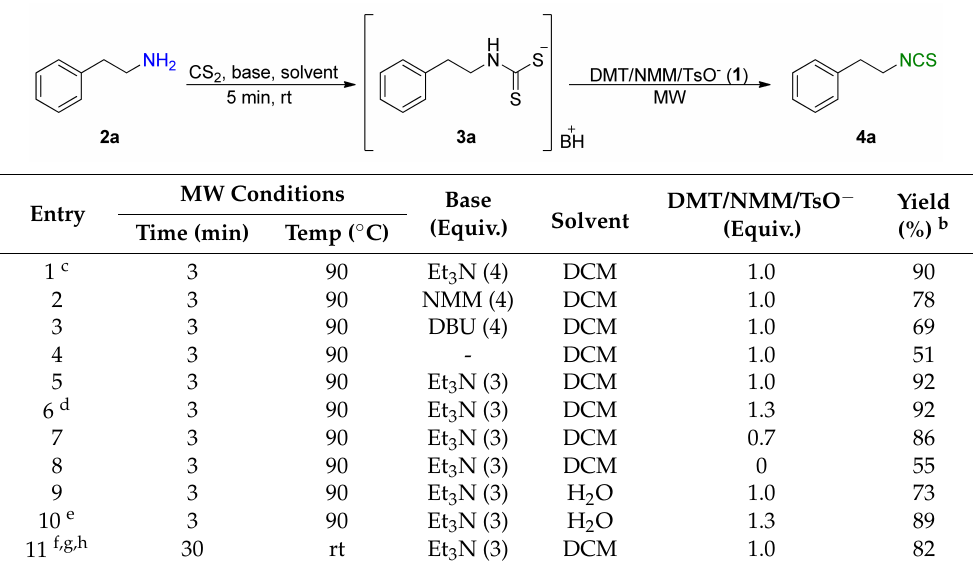
Table 1. Optimization of conditions of synthesis of isothiocyanate 4a , derived from model amine 2a a